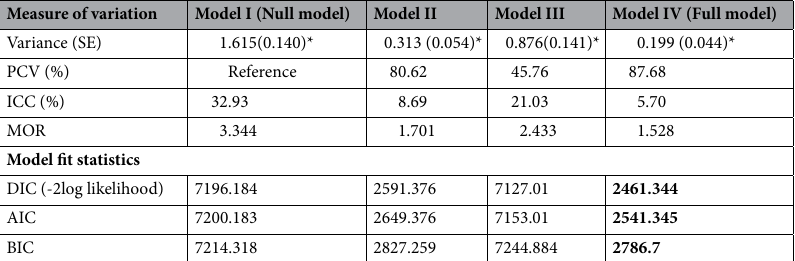
Table 4. Measure of variation on individual and community level risk factors of infant death in rural Ethiopia, EDHS 2016 dataset. *reference P -value < 0.0001. AIC Akaike’s information criterion, BIC Bayesian’s information criterion, DIC Deviance information criterion, ICC Intra-cluster correlation, MOR Median odds ratio, SE Standard Error, PCV Proportional change in